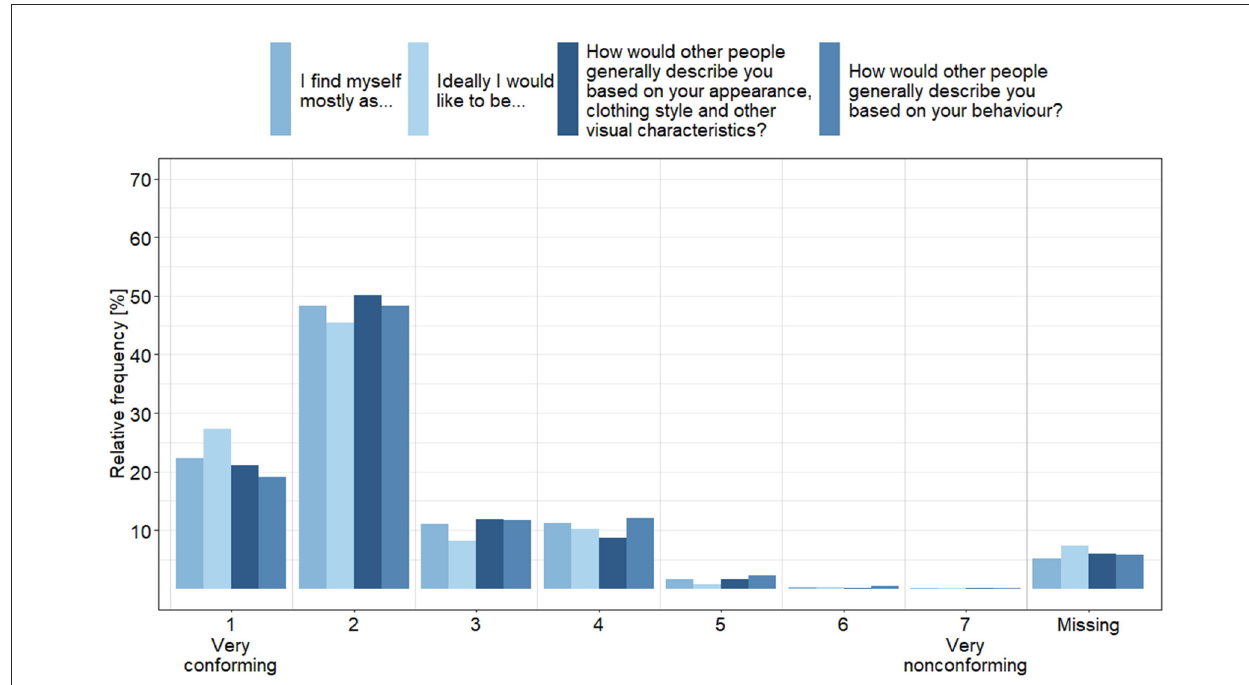
FIGURE1 Socially assigned gender (non)conformity, based on sex assigned at birth, separately for the two items for internalized sex/gender roles and the two items for externalized sex/gender expression, which were answered on a 7-point scale from “very masculine” to “very feminine” ( N =